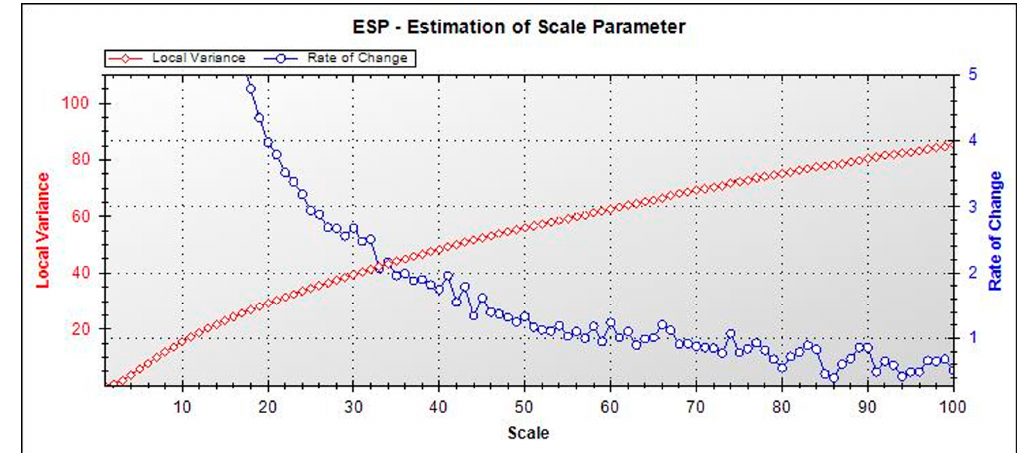
Figure 4. Local variance and its rate of change graph calculated by the ESP tool.